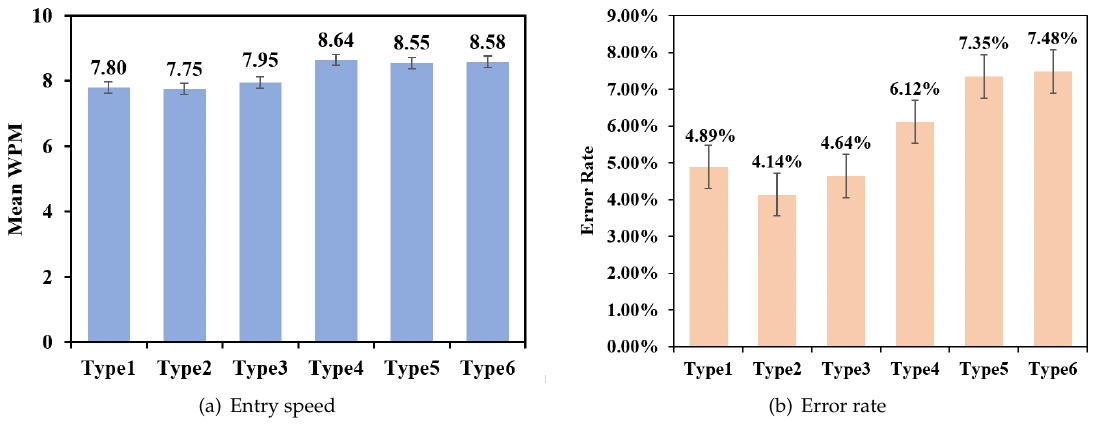
Figure 11. Mean text entry speed ( a ) and mean error rate ( b ) of 6 different placement modes.